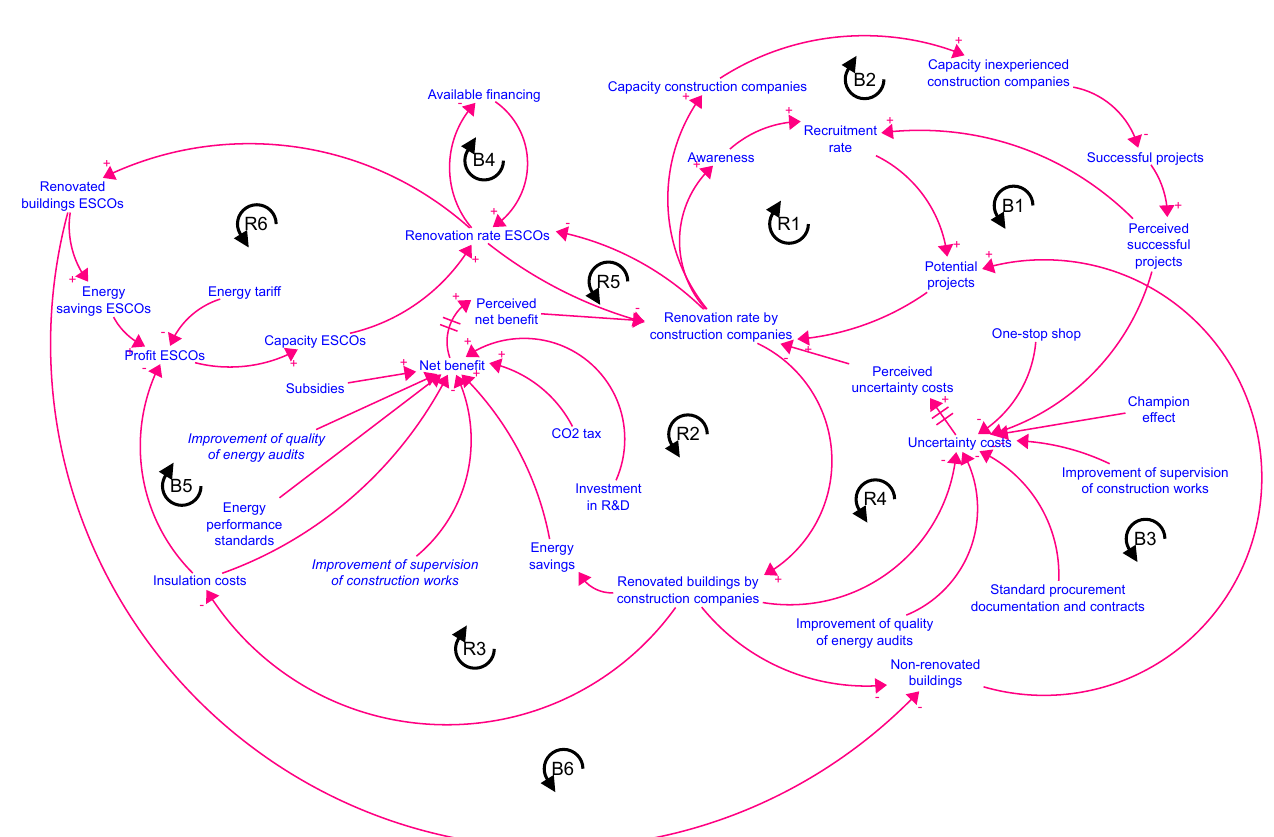
Figure 5. Broad causal loop diagram for the residential energy efficiency improvement process. Reinforcing loops are shown with symbols “R” and balancing loops are shown with symbols “B”.